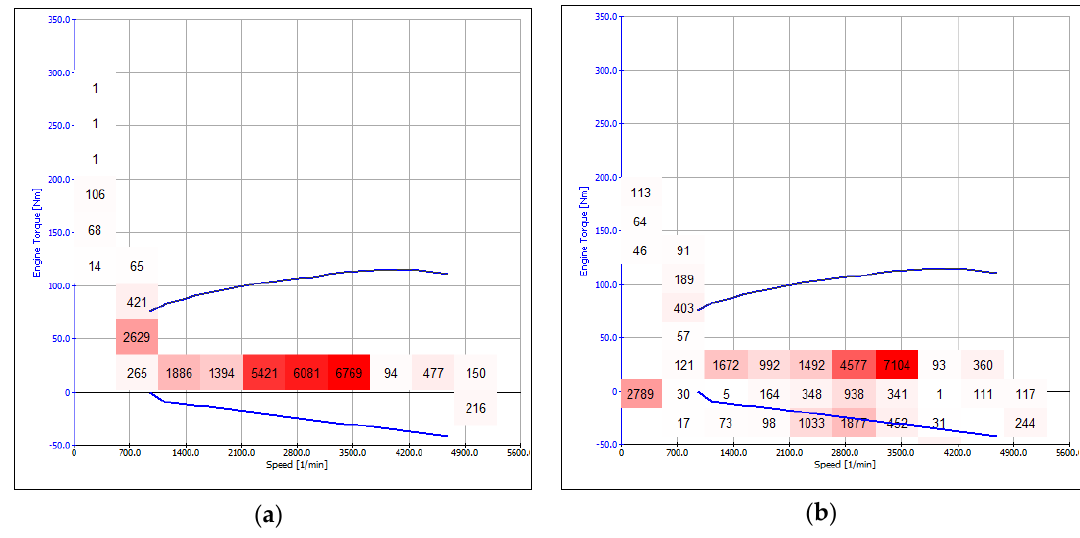
Figure 20. Comparison of engine optimized operating points in NEDC cycles: ( a ) F-EMS; ( b ) NNF-EMS.